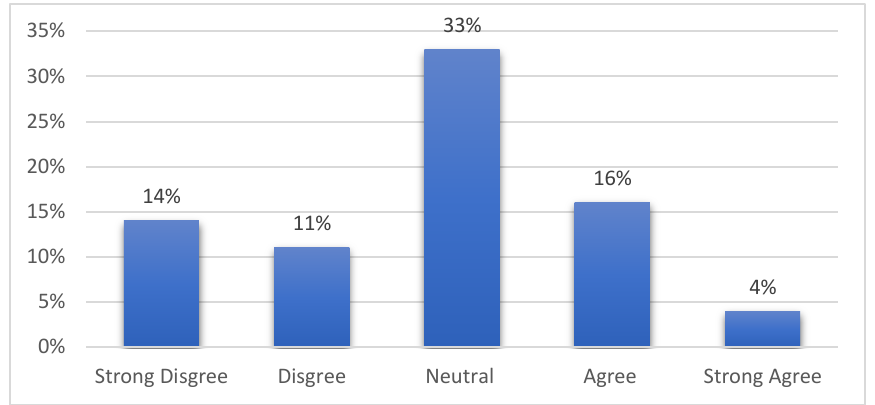
Figure 5: Staff attitude and